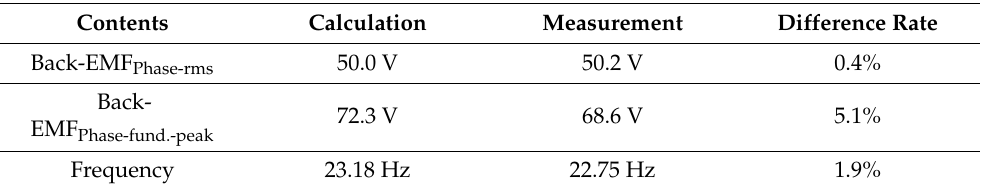
Figure 16. Measurement and calculation wave comparison of no-load phase Back-EMF of 4.5kW-class MG-PMSM prototype (pole piece/PM rotor@214/155 rpm): ( a ) Experimental wave; ( b ) Calculated wave. Table 8. Comparison results between calculated value and measured value of no-load Back-EMF at rated speed (pole piece/PM rotor@214/155 rpm).